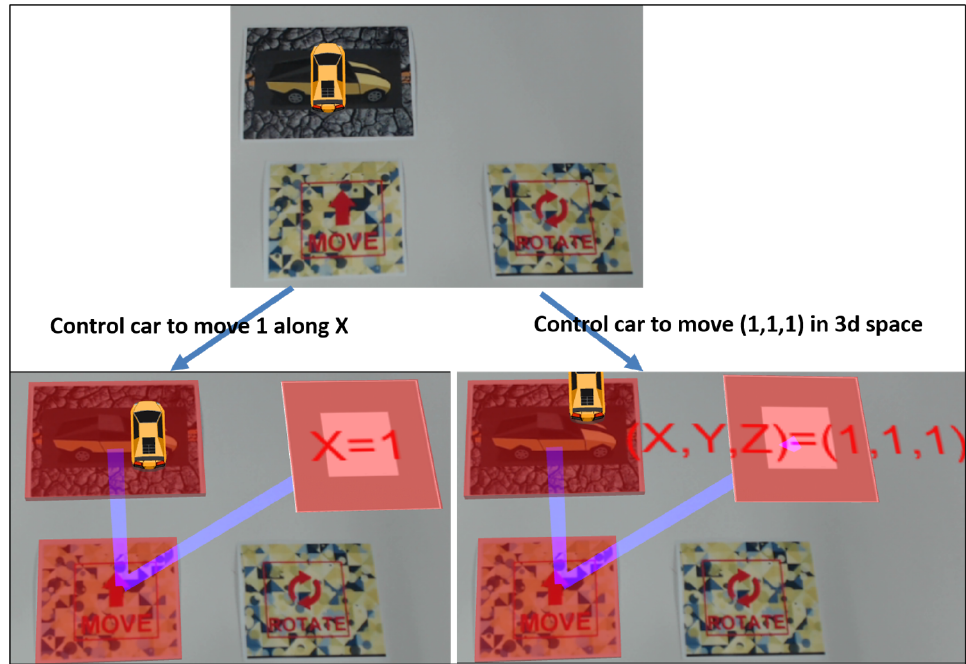
Figure 8. Use virtual markers to control the 2D and 3D movement of a car. In the figure above, the user can connect the car marker and any control marker to control the movement or rotation of the car. In the two pictures below, we provide users with combined virtual markers as parameters for the movement and rotation of the car. When a virtual marker is also selected and the user clicks on the moving marker, the car will move according to the parameter. In the example in the left figure, the car will move 1 along the X -axis and move in space along a 3D vector (1, 1, 1) in the right figure. Similarly, the user can also control the rotation of the car in this